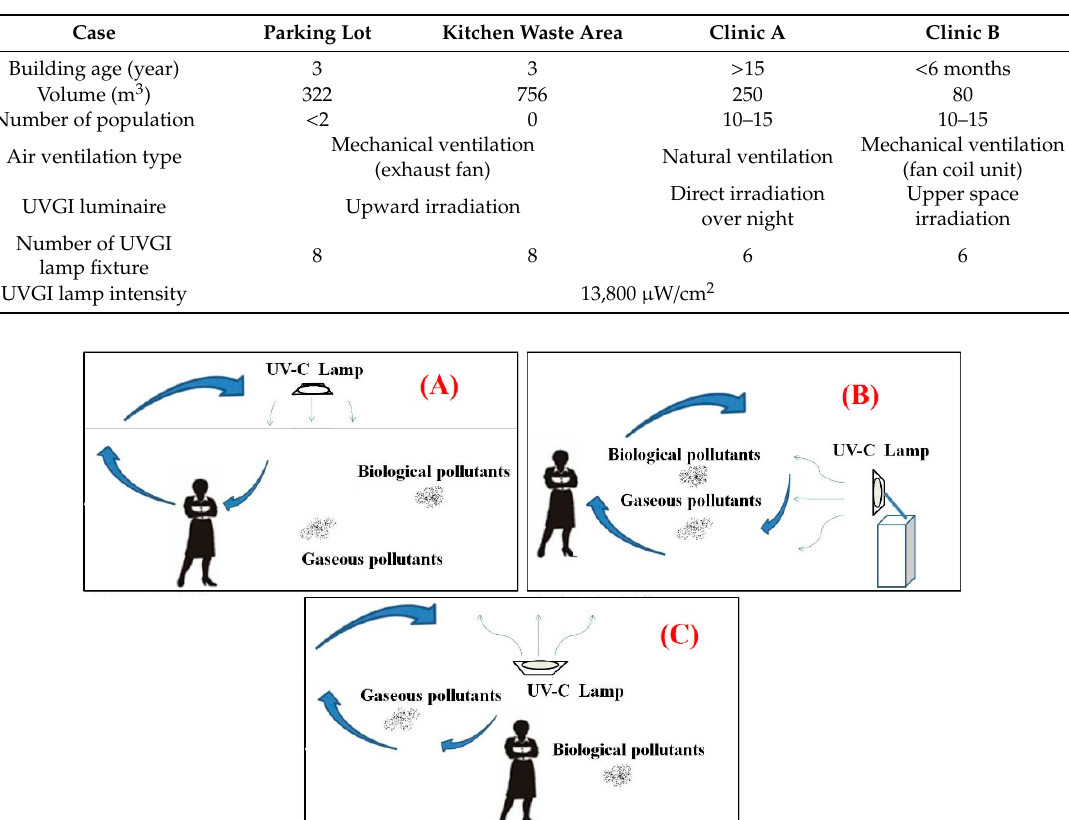
Table 1. Details of building information and UVGI application for field studies.